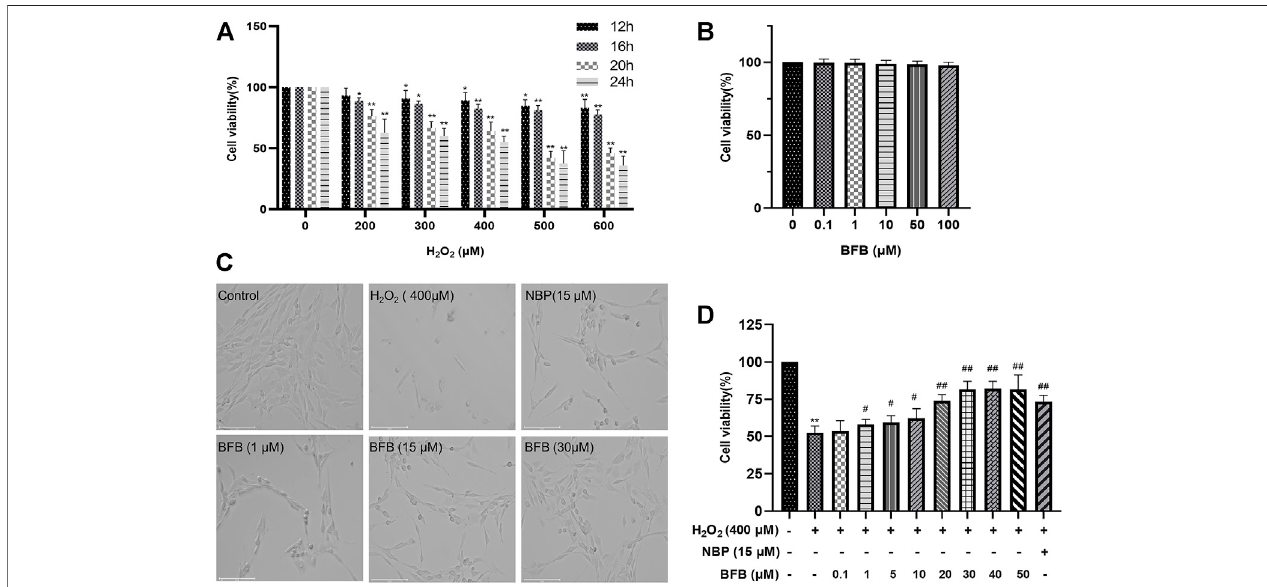
FIGURE 1 | BFB ’ s role in H 2 O 2 -induced PC12 cell viability (A) H 2 O 2 at different doses (0, 200, 300, 400, 500, 600 μ m) was added to treat PC12 cells for a 24-h period,thenCCK-8assayswereconductedtoassesscellviability (B) BFB(0.1,1,10,50,100 μ m) ’ scytotoxicitytoPC12cellswasanalyzedbyCCK-8assaysfora24-h period (C) Bright- fi eld images revealed H 2 O 2 -induced cell loss and alterations in cell morphology, which were remarkably abolished by administering BFB (scale bar = 125 μ m) (D) Concentration-response curve for H 2 O 2 -induced PC12 cell viability. 400 μ m H 2 O 2 and low-glucose DMEM were added to treat PC12 cells for a 24-h period, with pretreatment with BFB (0.1 – 50 μ m) or NBP (15 μ m) for 3 h respectively. Data were analyzed by mean ± SD from 3 separate assays. * p < 0.05, ** p < 0.01, versus control, # p < 0.05, ## p < 0.01, versus H 2 O 2